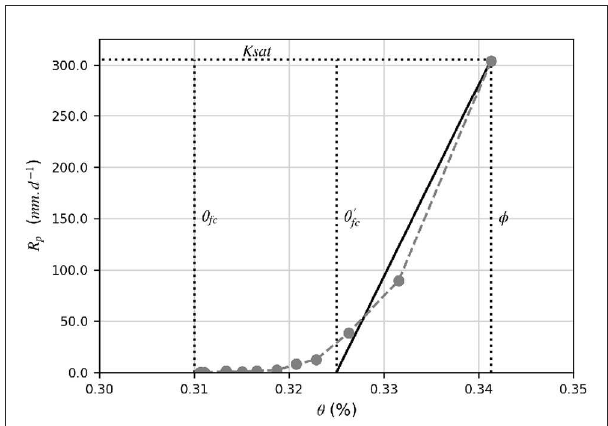
FIGURE3 Linear relationship (black straight line) between soil moisture ( θ ) and soil percolation ( R p , Equation 3). The gray dots represent the experimental percolation rates measured on a soil sample (silty loam) from the study area, first saturated and next exposed to free drainage. φ , porosity; θ fc , experimental soil moisture at field capacity; θ ′ fc , model-adjusted soil moisture at field capacity; Ksat , saturated hydraulic